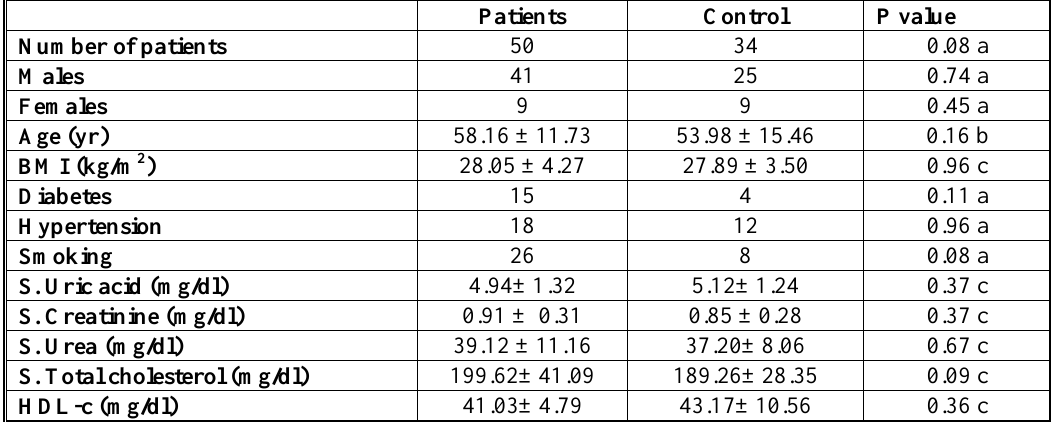
Table 1: Demographic, clinical characteristics and baseline laboratory variables of the study groups.